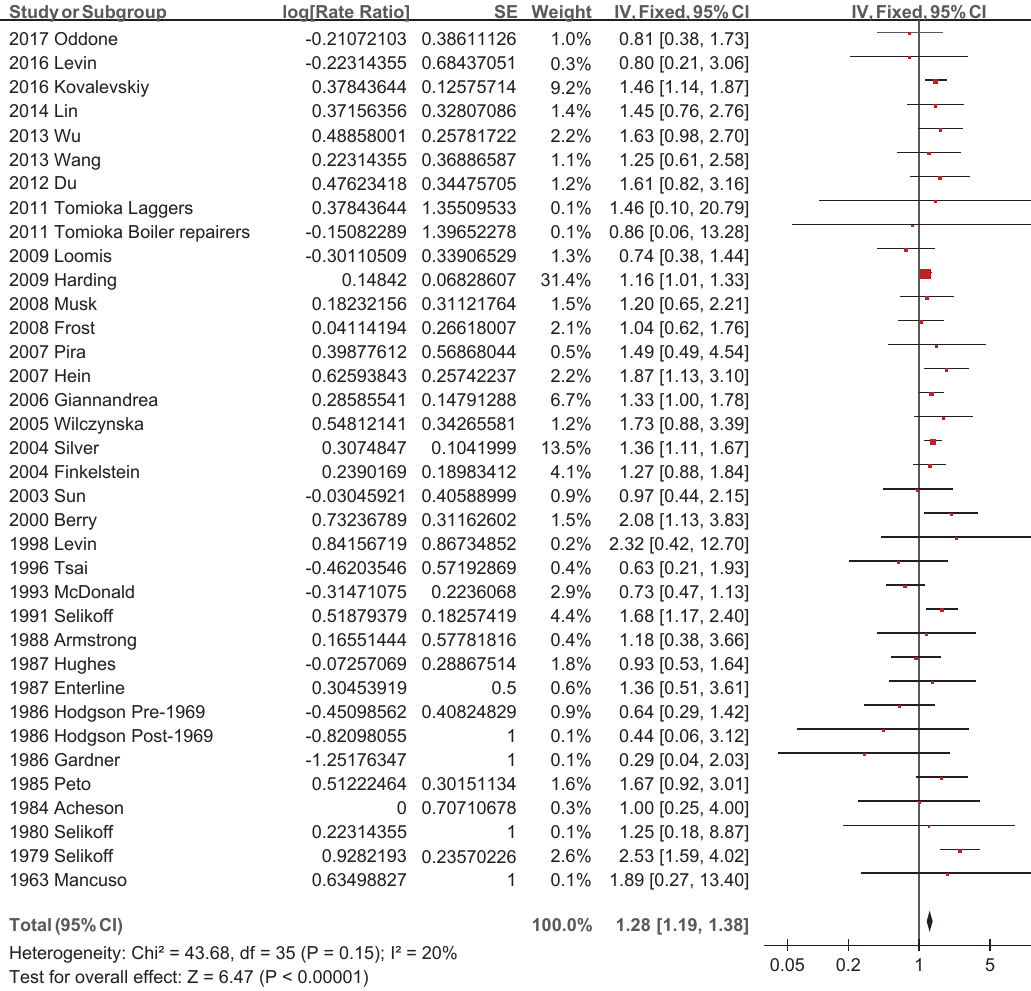
Figure 2. Asbestos exposure and standardized mortality ratio (SMRs) of esophageal cancer in the 33 studies: a fixed- effect